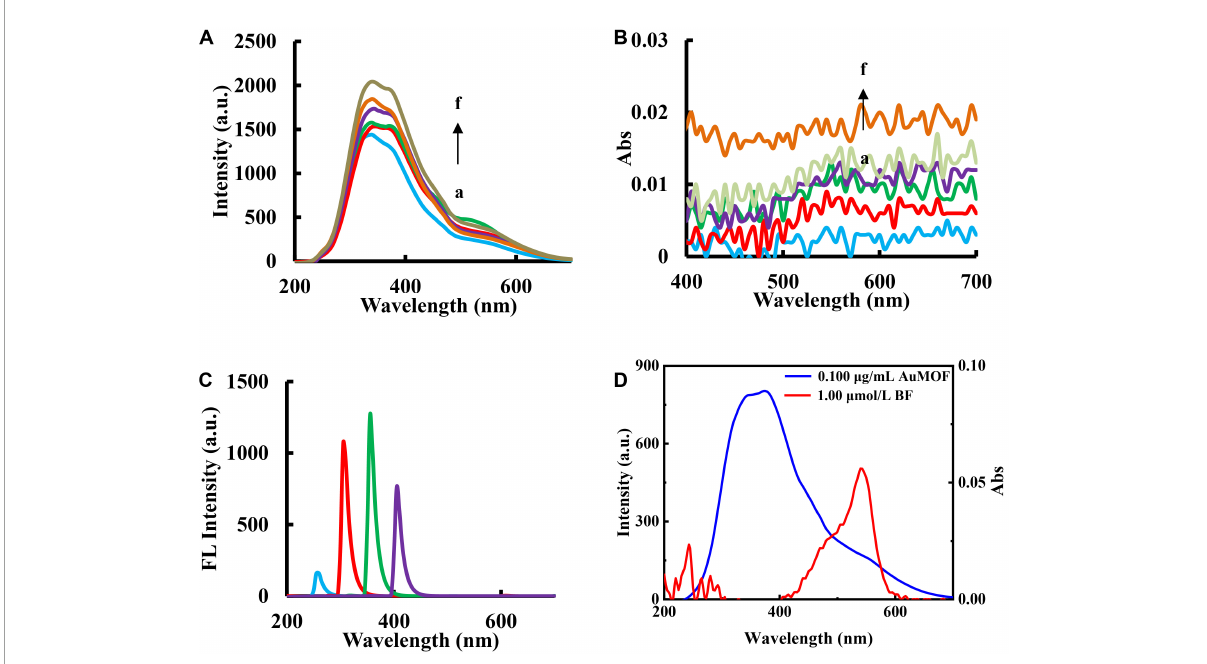
FIGURE3 RRS, UV-Vis absorption and fluorescence spectra of AuMOF nanosol. (A) a–f curves represent: RRS spectra of (0.100, 0.200, 0.400, 0.800, 20.0, 50.0 µ g/mL) AuMOF. (B) a–f curves represent: UV-Vis absorption spectra of (0.100, 0.200, 0.400, 0.800, 1.00, 20.0 µ g/mL) AuMOF. (C) Fluorescence spectra of 0.800 µ g/mL AuMOF (excitation wavelengths = 250, 300, 350, 400 nm). (D) Relationship between the RRS of AuMOF and the absorption spectrum of